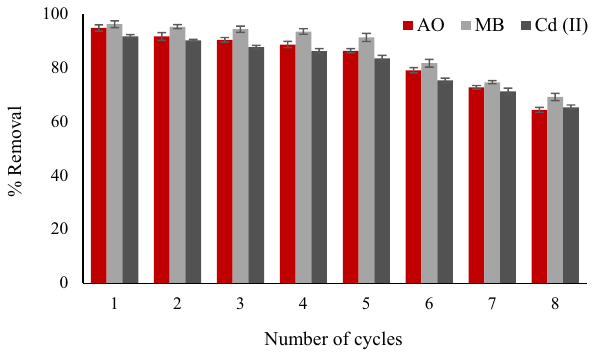
Figure 5. Desorption performance of ZF-NPS in seven regeneration cycles (Removal conditions: adsorbent amount 0.25 g, pH = 6, sonication time 15 min, and concentration 15 mg L −1 ).